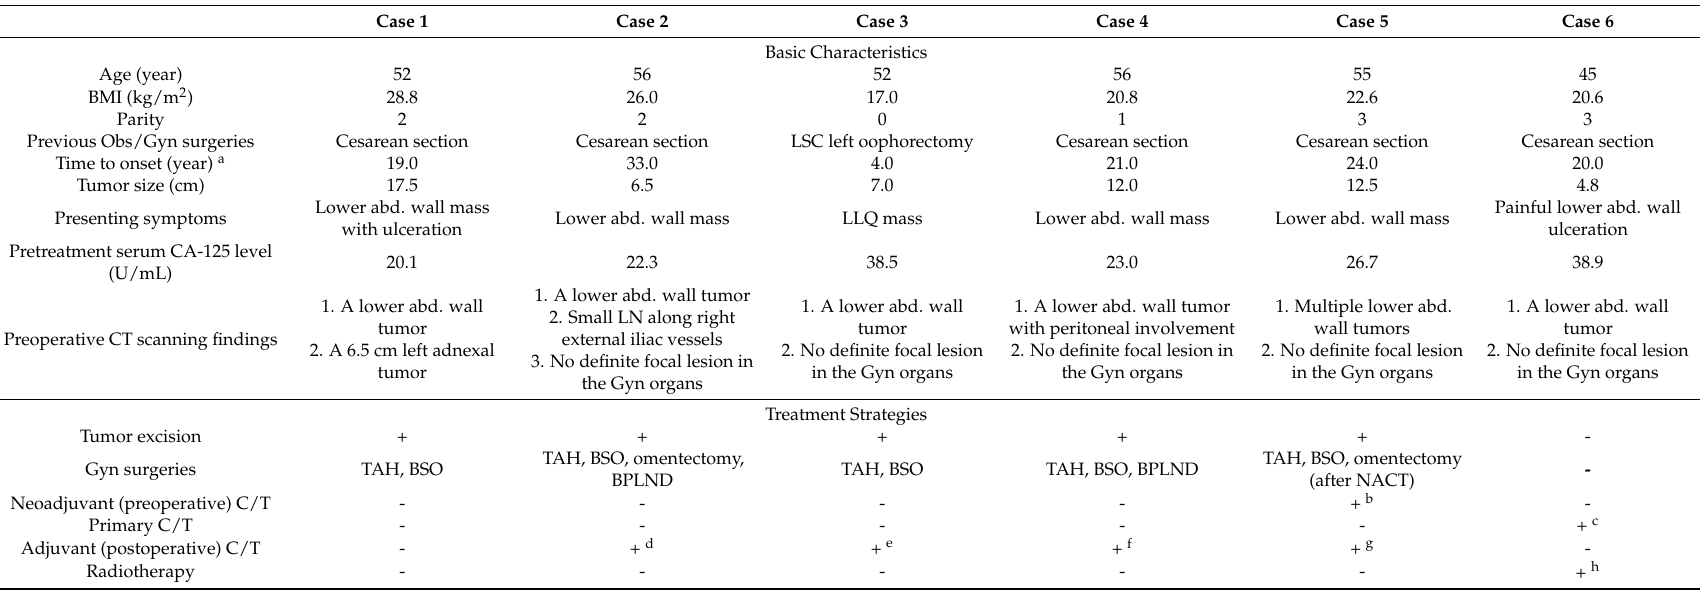
Table 1. Clinicopathologic characteristics of the six patients with clear cell carcinoma of the abdominal